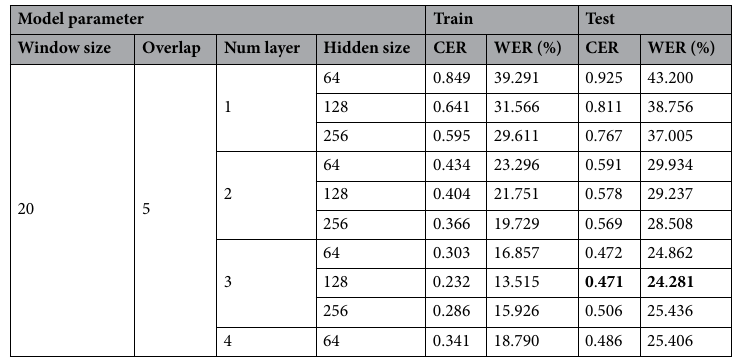
Table 6. Num layer and hidden size tuning experiment result. Significant values are in [bold].